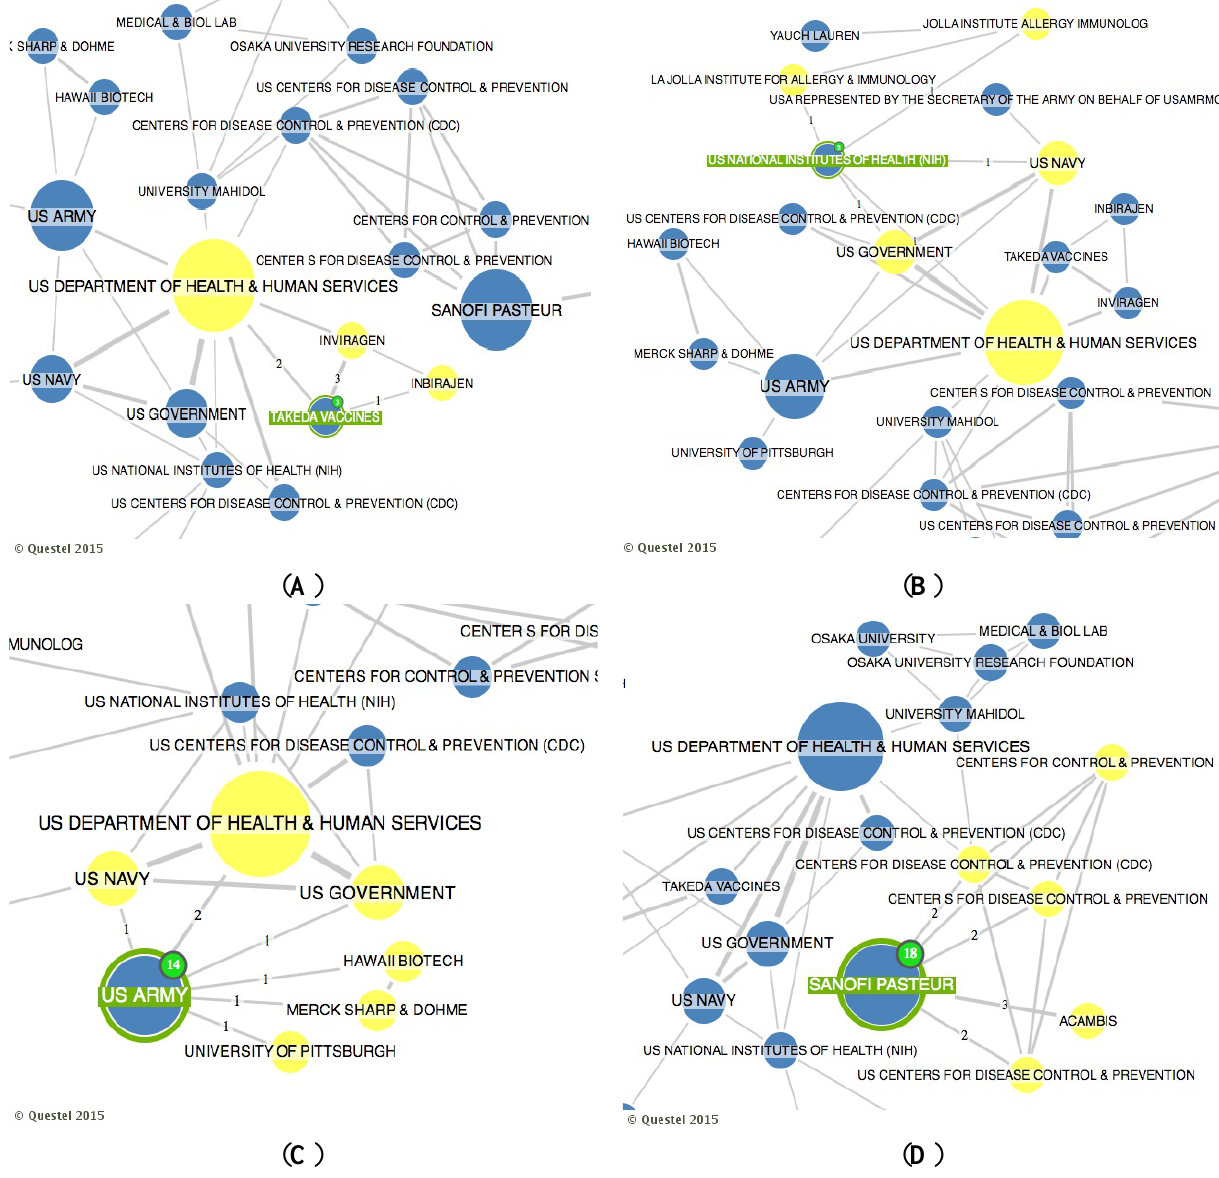
Figure 5. Distribution of search results by main co-ownerships of late-stage dengue vaccine developers. Part A : co-ownership of Takeda; Part B : co-ownership of US National Institute of Health; Part C : co-ownership of US Army; Part D : co-ownership of Sanofi